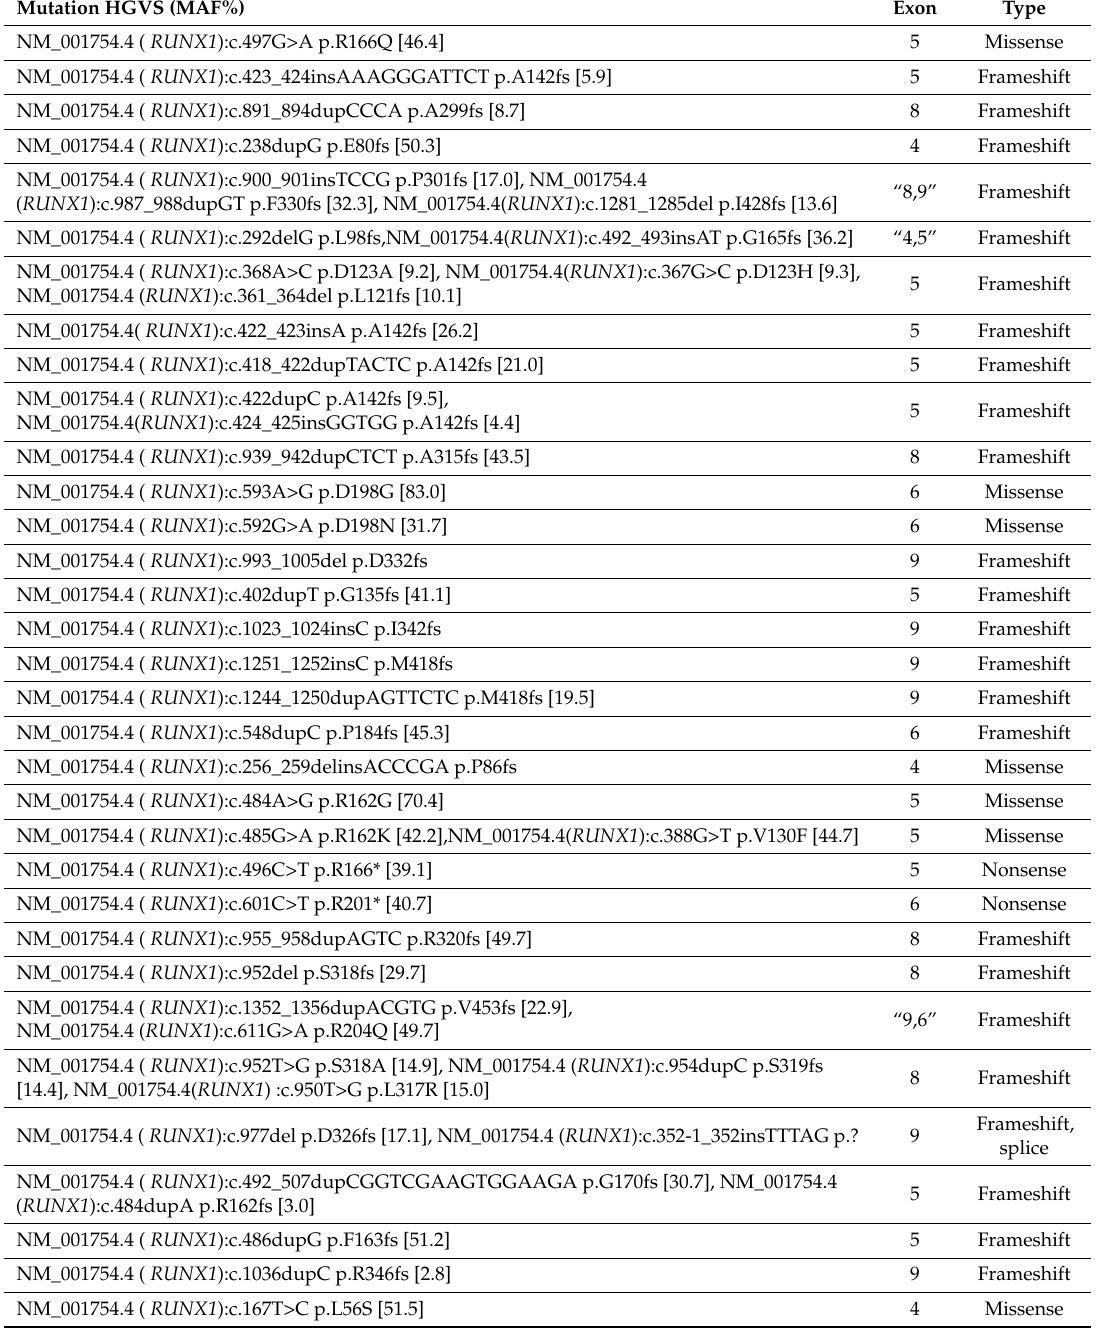
Table A1. RUNX1 mutations according to their minor allele frequency, exon location, and mutation